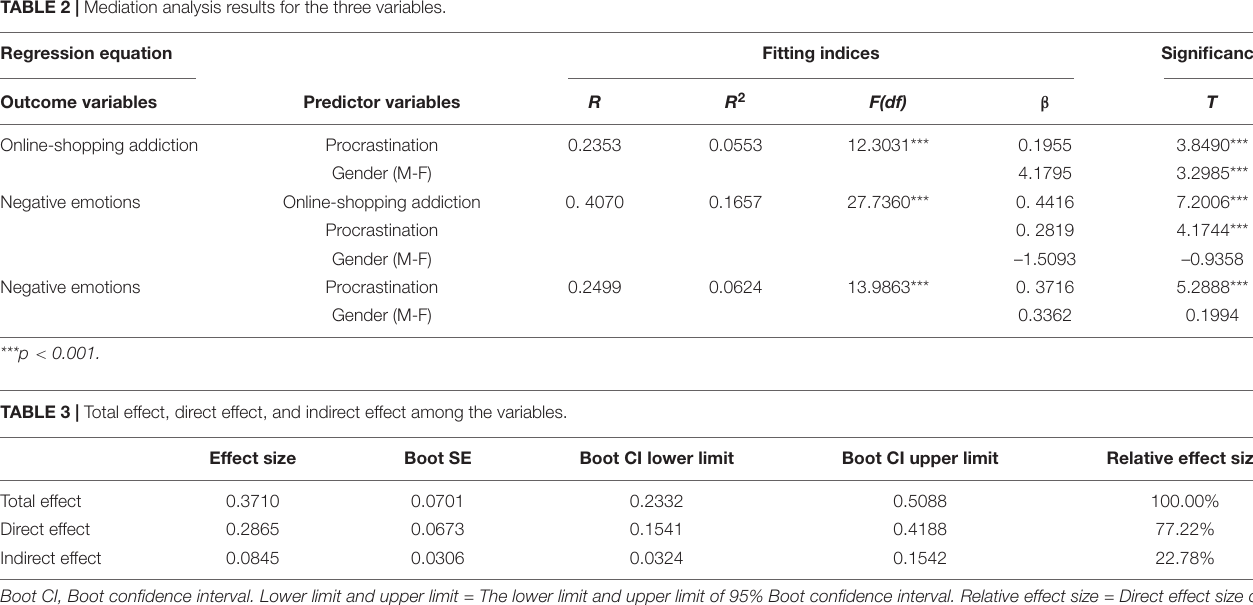
TABLE 2 | Mediation analysis results for the three variables.